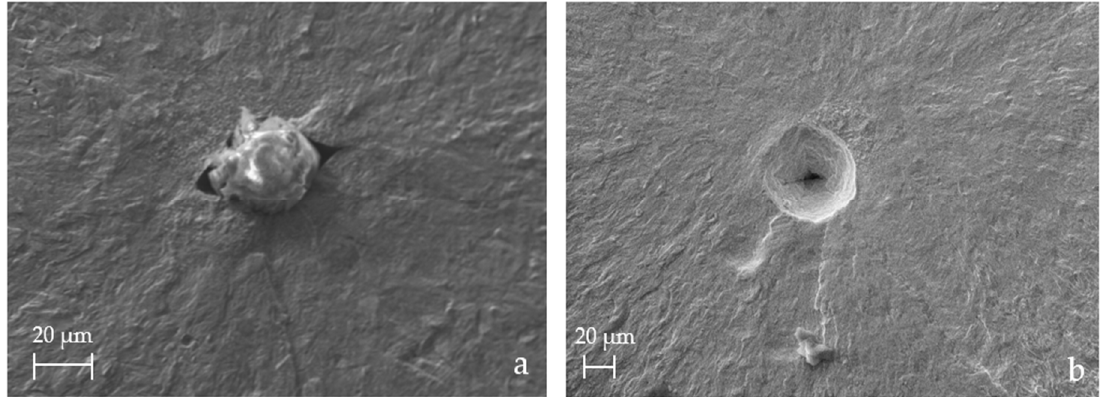
Figure 5. SEM images from two typical non-metallic inclusion shapes. ( a ) Eye-shaped inclusion with two sharp edges—HT specimen; ( b ) Round inclusion—TMT specimen.